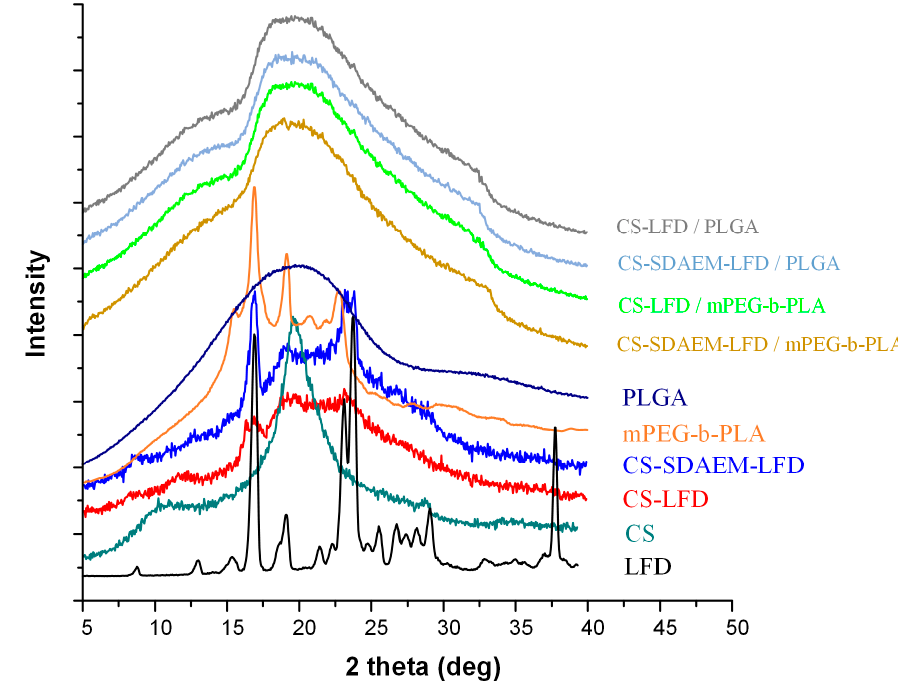
Figure 10. pXRD diffractograms of mPEG-b-PLA and PLGA thin-films with LFD-loaded NPs.